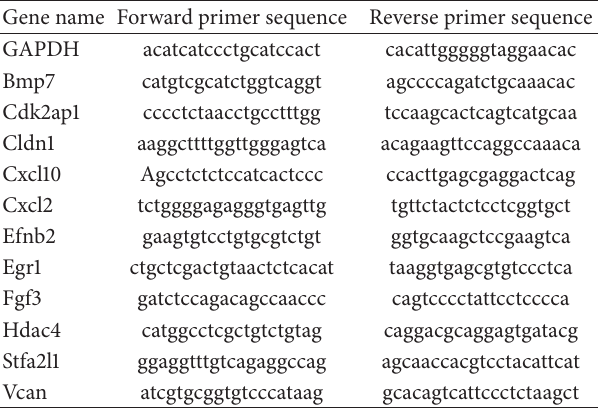
Table 1: The primers for quantitative real-time